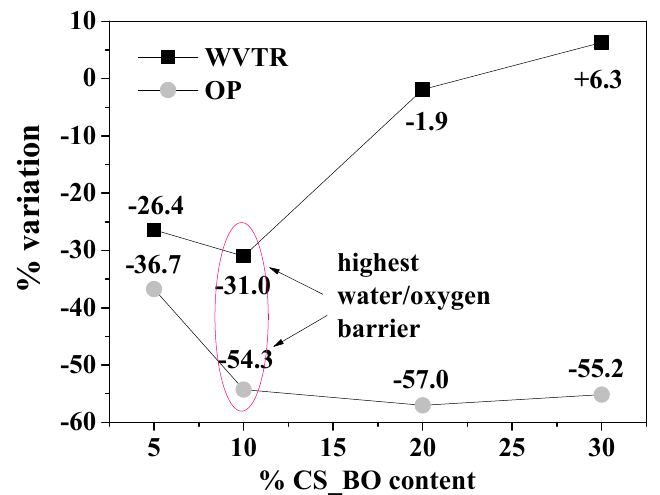
Figure 8. % Water Vapor Transmission Rate (WVTR) and Oxygen Permeability (OP) mean value variation of each LDPE/CS_BO composite sample as compared to the mean values of the WVTR and OP of pure LDPE film.